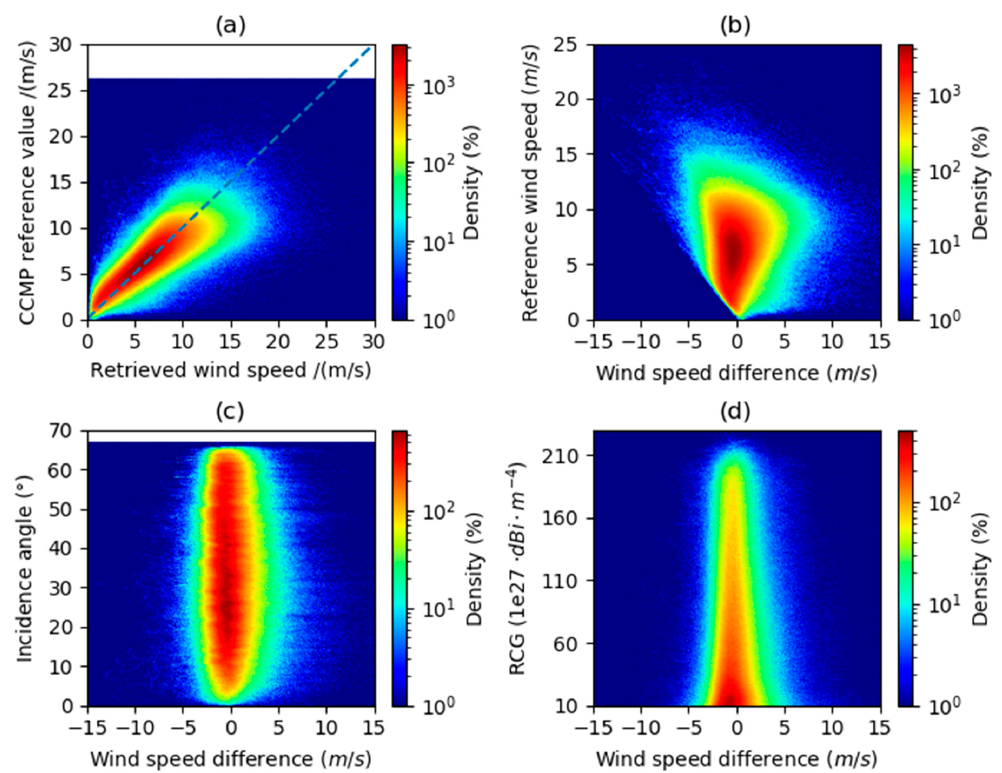
Figure 10. Log(density) scatterplots of retrieved wind speed with the CCMP ground truth wind speed ( a ), residual versus truth wind speed ( b ), incident angle ( c ), and RCG ( d ).